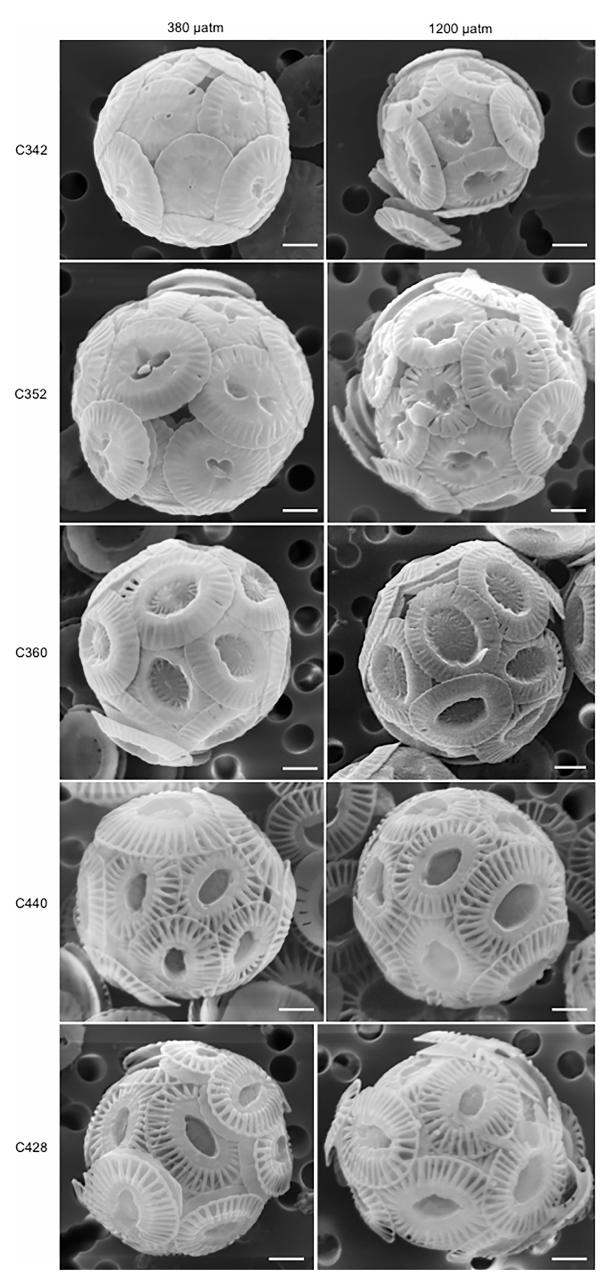
Figure 4. Representative coccospheres from each strain and treat- ment tested in the experiment. CHC342 was isolated from the Pa- cific coast of Isla de Chiloé (41.9 ◦ S, 74.0 ◦ W) in November 2012. CHC352 and CHC360 were isolated from the Punta Lengua de Vaca upwelling center (30.3 ◦ S, 71.7 ◦ W) in November 2012. CHC440 and CHC428 were isolated from the station farthest west in the Pa- cific (station H10, at 16.7 ◦ S, 86 ◦ W) during the NBP1305 cruise in July 2013.